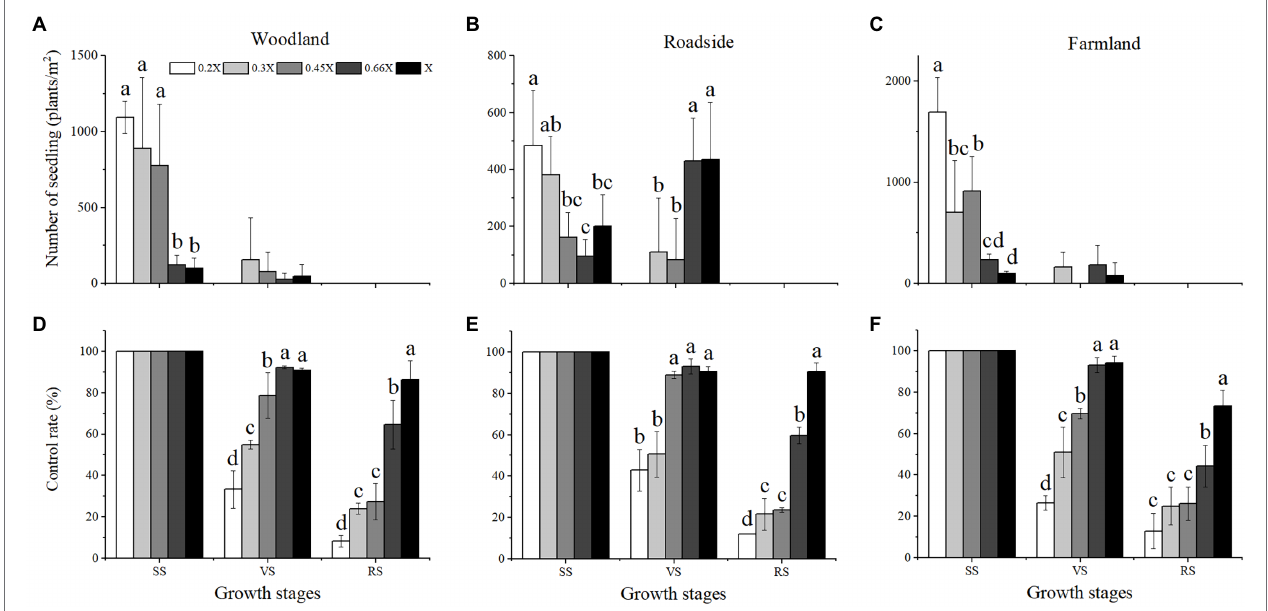
FIGURE 2 | Regeneration (A–C) and control rate (D–F) of Ambrosia artemisiifolia under different treatments. Habitats and growth stages: W, woodland; R, roadside; F, farmland; SS, seedling stage; VS , vegetative growth stage; and RS, reproductive growth stage. 0.2X, 0.3X, 0.45X, 0.66X, and X represent different doses of aminopyralid. Intercomparison between different aminopyralid doses within the same treatment time. Different letters indicate significant differences, while treatments without marked letters indicate non-significant differences ( p < 0.05). Values are means ±